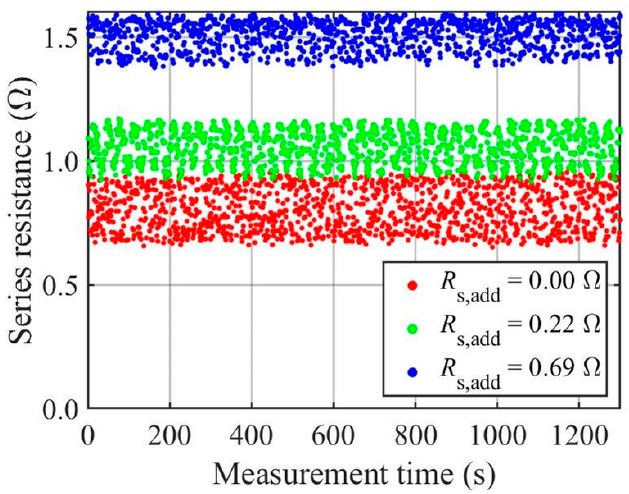
Figure 21. Fitted series resistance values using additional series resistors as a function of measurement time when using the cutting limit of 20% based on MPP power for I – U curves. Table 5. Statistical quantities for series resistances identified from 1300 consecutive I – U curves using the entirely measured I – U curves (cutting limit of 100%) and partial I – U curves with the cutting limits of 50% and 20% of MPP power for fitting.